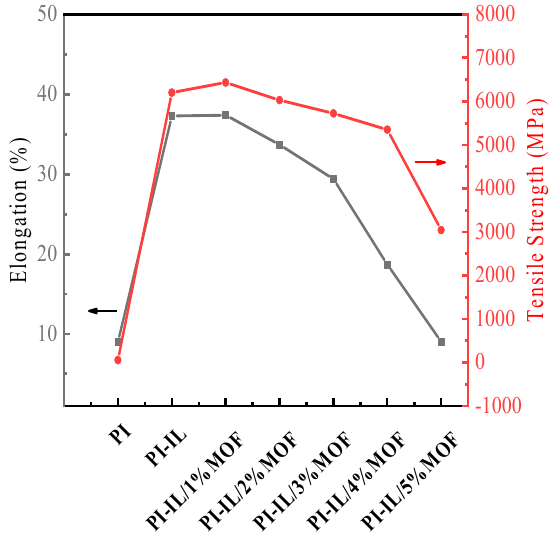
Figure 4. Mechanical properties of PI (PI), PI-IL (PI-IL) and PI-IL/x% (1%, 2%, 3%, 4% and 5%) MOF mem- branes.